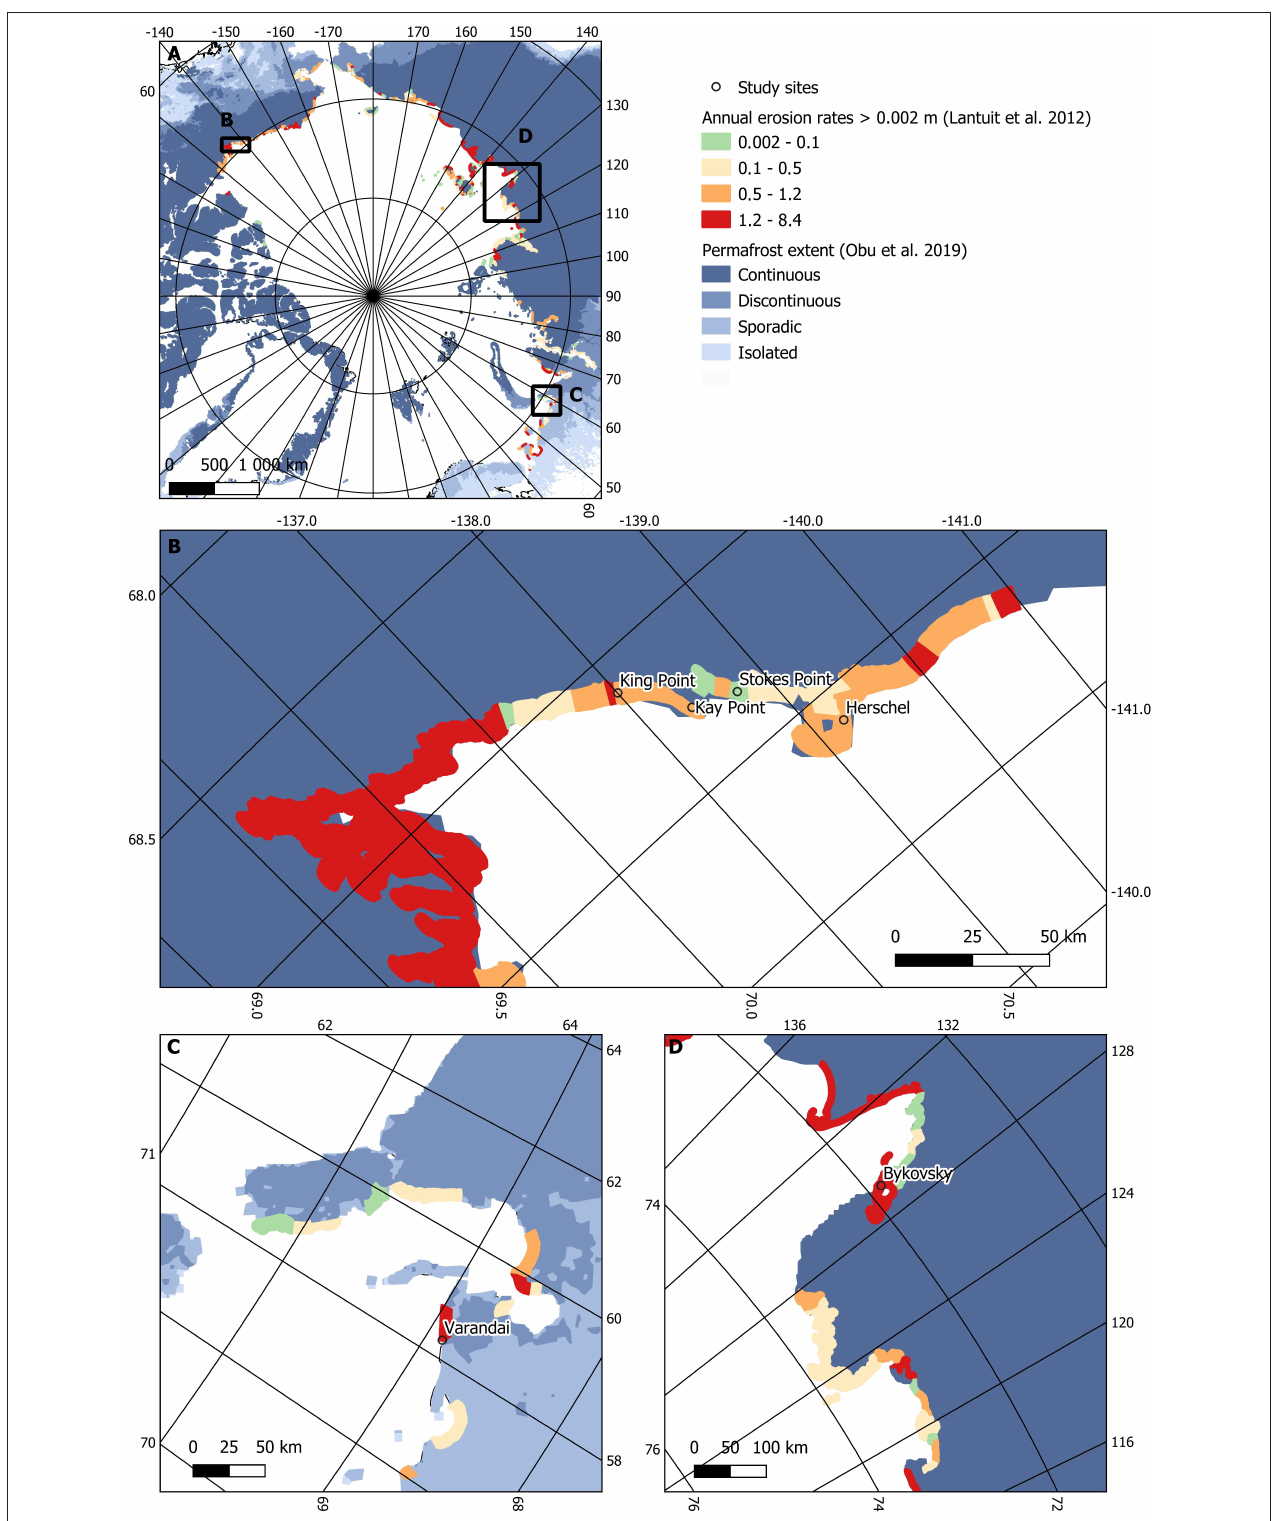
FIGURE 1 | (A) Location of study areas, annual erosion rates (source: Lantuit et al., 2012) and permafrost zones (source: Obu et al., 2019b). (B) zoom for Beaufort Sea coast, (C) zoom for Barents Sea Coast, (D) zoom for Laptev Sea Coast.